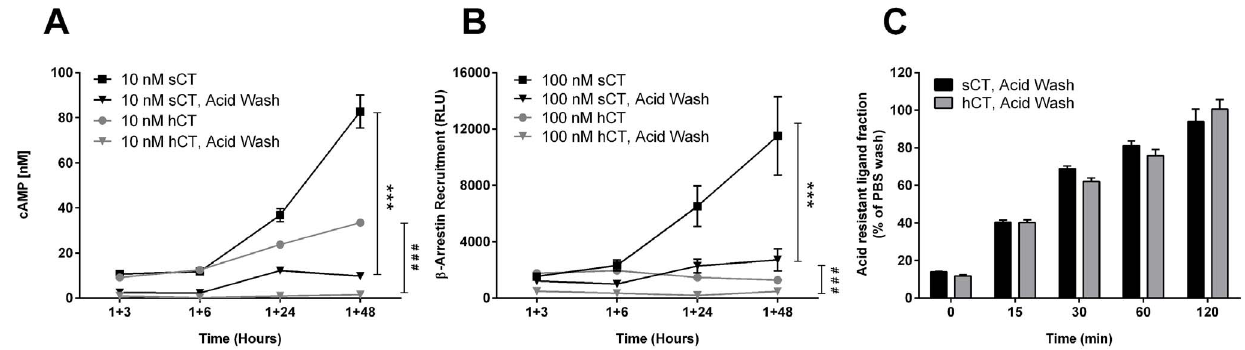
Figure 5. Acid wash decrease, but do not attenuate sCT mediated prolonged cAMP and b -arrestin signaling. Effects of acid wash on cAMP production (A) and b -arrestin recruitment (B). U2OS CALCR cells were initially stimulated for 60 min with sCT or hCT using U2OS CALCR cells, then acid washed for 2 6 2 min and cultured for another 3, 6, 24 or 48 hours in fresh ligand free culture medium, and then assayed at end incubation. In parallel, standard assay groups of sCT and hCT were included as controls. C) Internalization rate of 125 I-sCT and 125 I-hCT stimulated CT (a) receptors in U2OS CALCR. Cells were pre-stimulated for 45 min at 4 u C with 0.25 nM 125 I-sCT or 0.25 nM 125 I-hCT for ensure receptor occupancy, then incubating for an additional 0, 15, 30, 60 and 120 min at 37 u C to assess internalization. Asterisk (*) indicates significant difference between AUC sCT, Not Washed and AUC sCT, Acid Wash. Asterisk ( # ) indicates significant difference between AUC hCT, Not Washed and AUC hCT, Acid Wash. p , 0.05 was considered to be significant. * =p , 0.05, ** =p , 0.01, *** =p , 0.001. cAMP data are shown as mean 6 SEM and representative of three individual conducted experiments with five replicates. b -arrestin data are shown as mean 6 SEM of 3 experiments performed with five replicates. Internalization data are shown as mean 6 SEM and representative of two individual conducted experiments in triplicates.